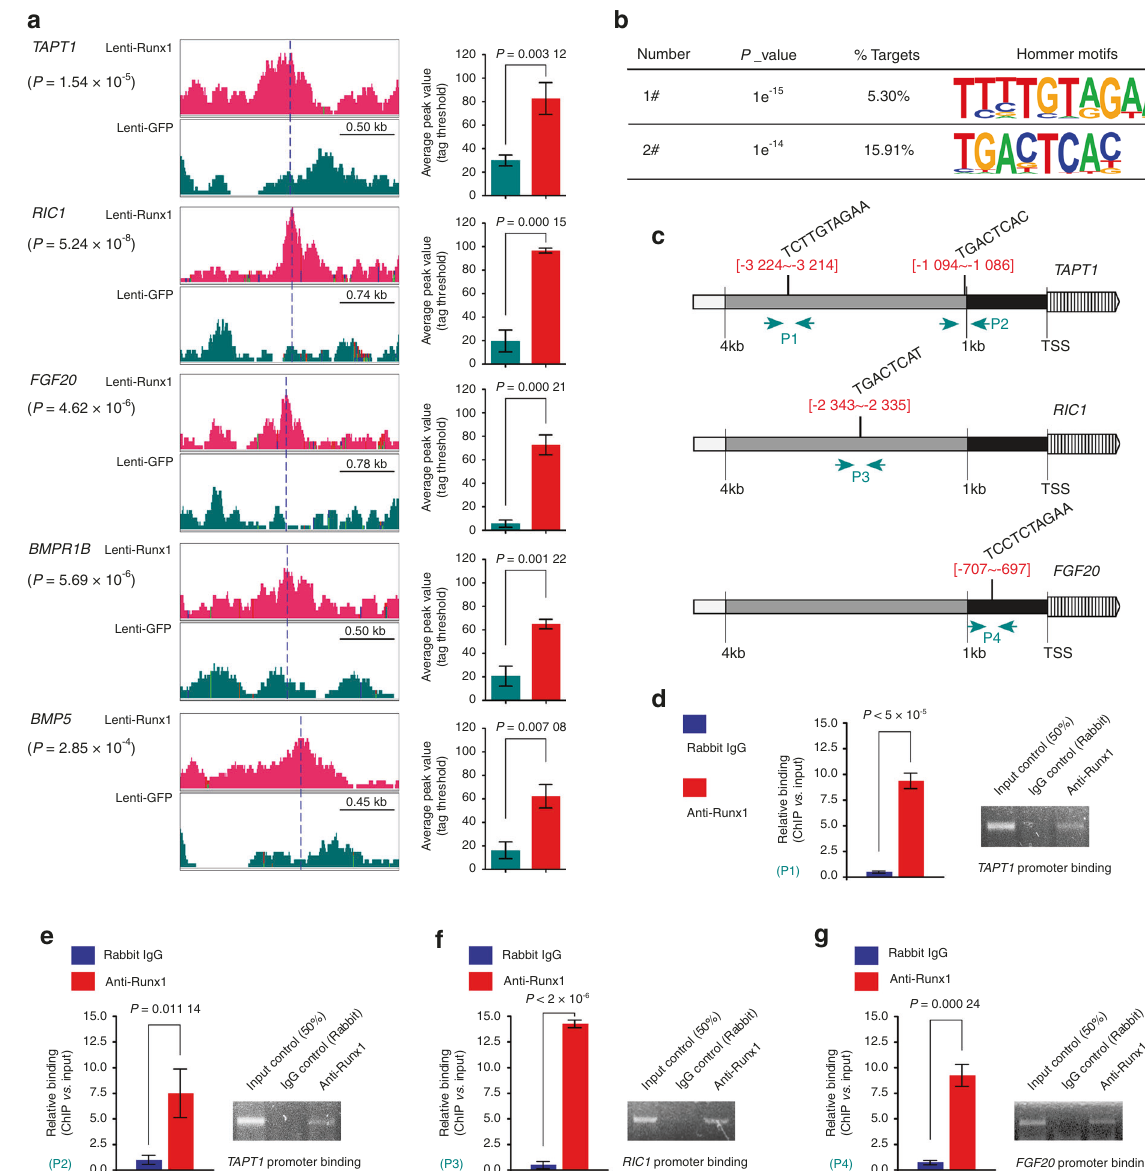
Fig. 6 Detailed binding of Runx1 to the promoters of target genes in the context of chondrocyte pathology. a Peak values of target genes in chondrocyte pathology were identi fi ed by using IGV analysis. The speci fi c average peak values are shown in the right histograms. b Motif analysis based on Runx1-ChIP-seq (hommer) identi fi ed two sequences at the promoter regions of these target genes in the context of chondrocyte pathology. c Bioinformatics analysis indicated the speci fi c locations of these two sequences in the promoters of the TAPT1 , RIC1 , and FGF20 genes. d ChIP-qPCR con fi rmed one binding site ( − 3 224 to − 3 214) of Runx1 in the promoter of the TAPT1 gene. Strip diagrams from electrophoretic gels based on ChIP-qPCR products con fi rmed this result. e ChIP-qPCR con fi rmed another binding site ( − 1 094 to − 1 086) of Runx1 in the promoter of the TAPT1 gene. Strip diagrams from electrophoretic gels based on ChIP-qPCR products con fi rmed this result. f ChIP-qPCR con fi rmed the binding site ( − 2 343 to − 2 335) of Runx1 in the promoter of the RIC1 gene. Strip diagrams from electrophoretic gels based on ChIP-qPCR products con fi rmed this result. g ChIP-qPCR con fi rmed the binding site ( − 707 to − 697) of Runx1 in the promoter of the FGF20 gene. Strip diagrams from electrophoretic gels based on ChIP-qPCR products con fi rmed this result. These results are based on at least three independent experiments ( n = 3). All signi fi cance data presented in a , d , e , f , and g are based on two-tailed Student ’ s t